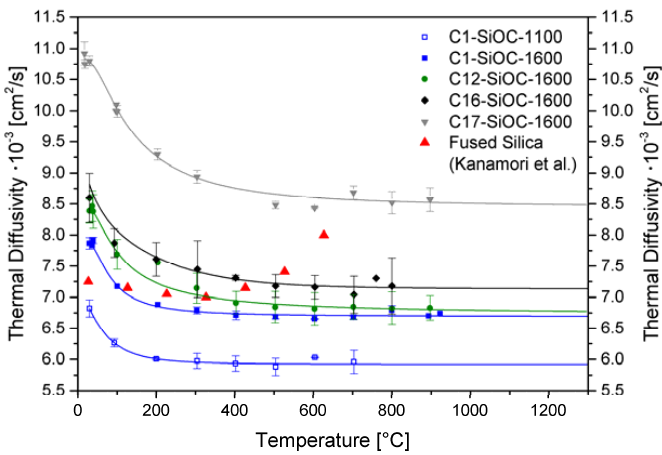
Figure 5. Thermal diffusivity of SiOC glass and glass ceramics. The data points represent the values measured, while the solid lines represent guidelines for the eyes. The data for fused silica are taken from Kanamori et al. [45].